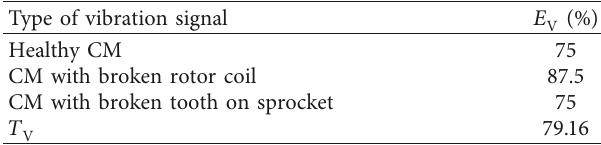
Table 10: The results of recognition of vibration signals—the MSAF-RATIO-50-SFC-EXPANDED and the backpropagation neural network were